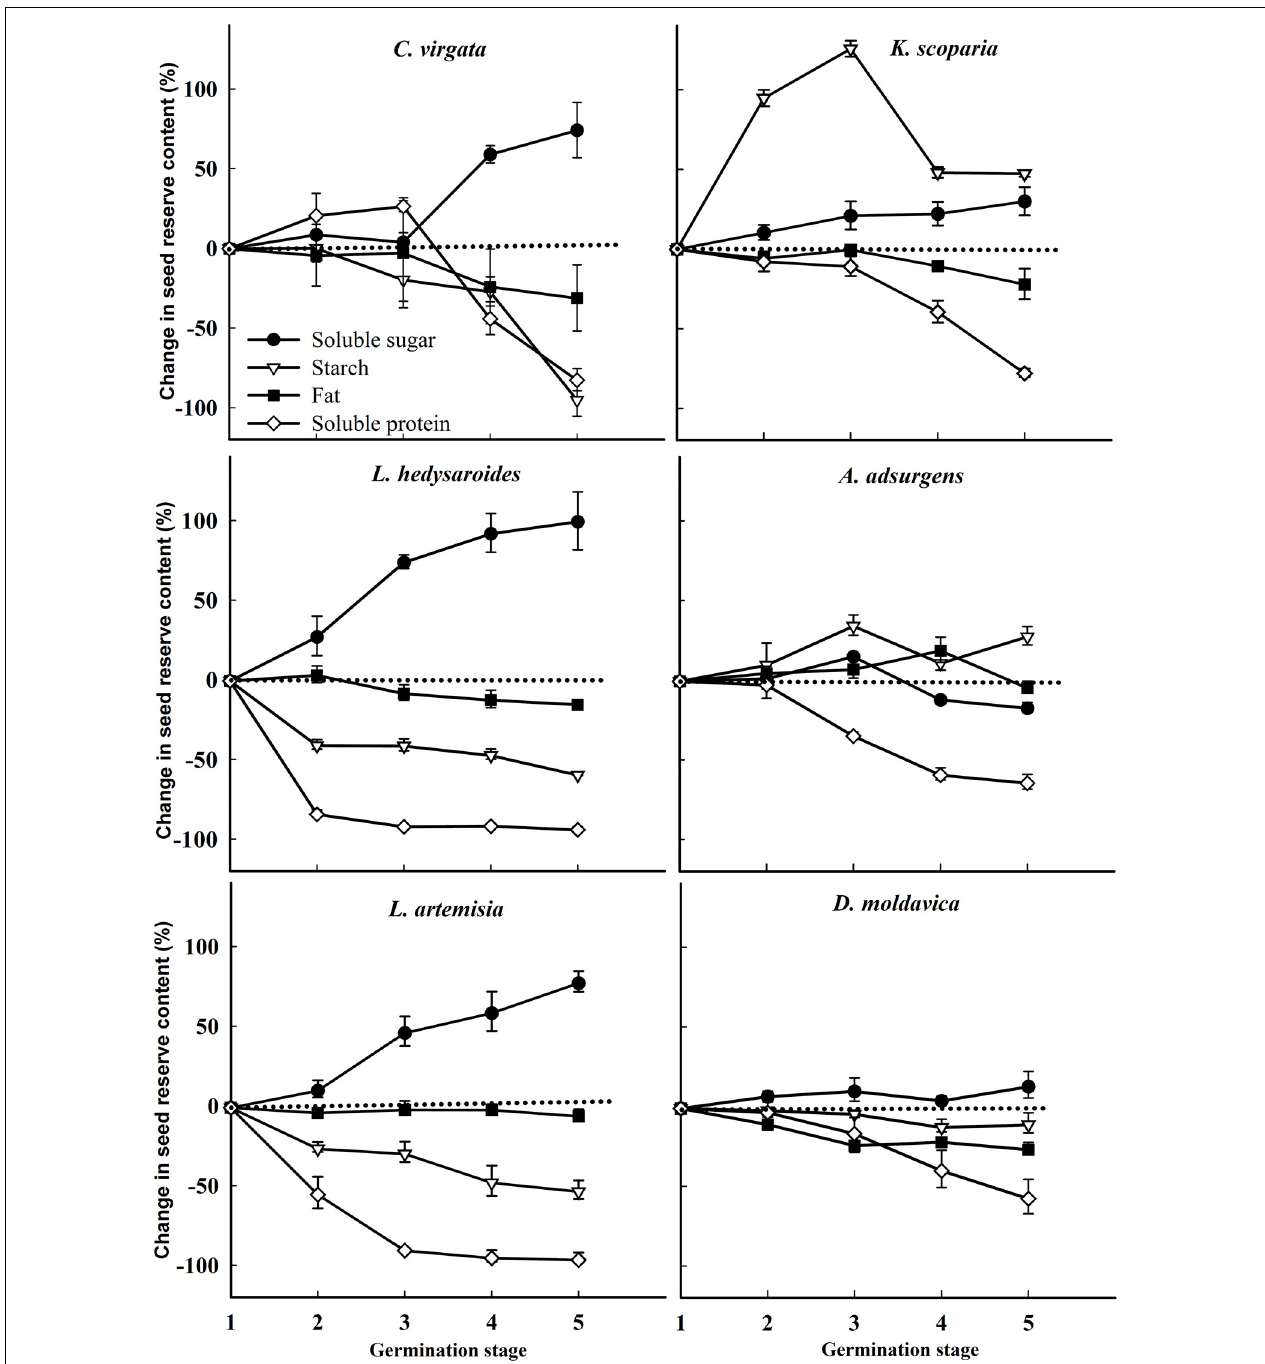
FIGURE 5 | Change (%) in seed reserve content (mg/g) for Chloris virgata , Kochia scoparia , Lespedeza hedysaroides , Astragalus adsurgens , Leonurus artemisia, and Dracocephalum moldavica at various germination stages (relative to imbibed seeds). (1) Imbibition; (2) 1% germination; (3) 50% germination; (4) highest germination; (5) early seedling. The change in seed reserves was calculated from data in Supplementary Table